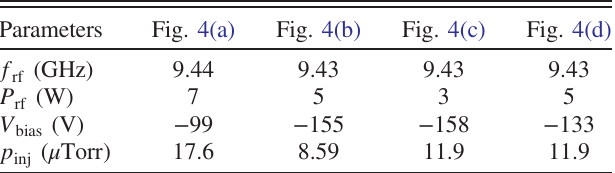
TABLE I. Tuning parameters of ECR ion source for various plasma instabilities generation with respect to Fig. 4.